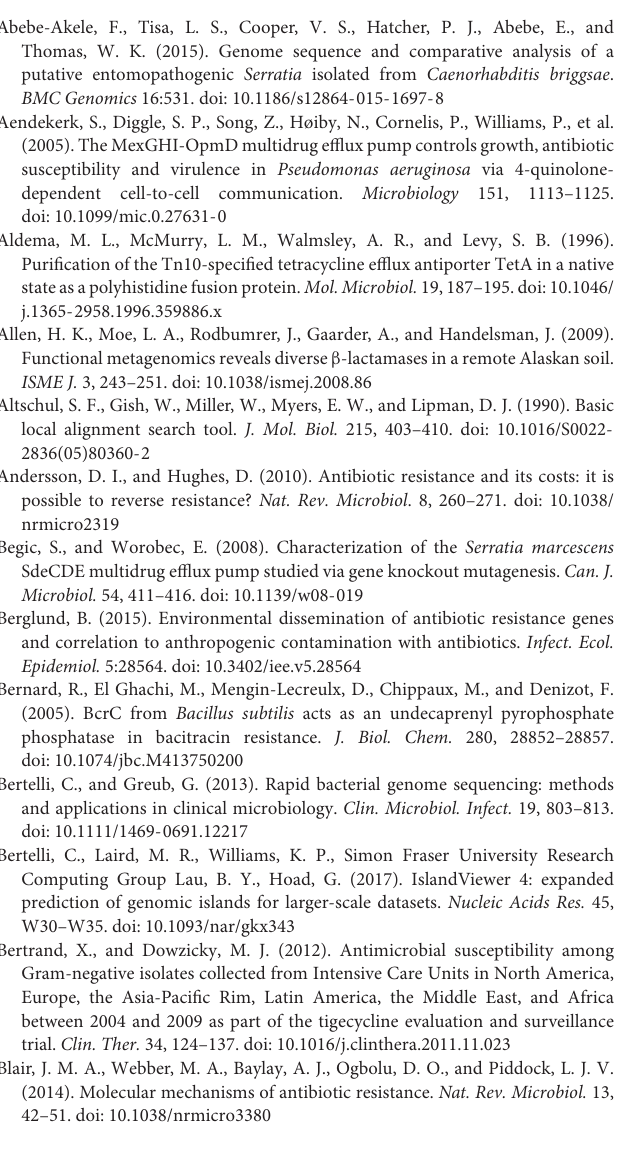
FIGURE S3 | Venn analysis of the pan-genome of the 32 Serratia spp. genomes generated by COG and OMCL algorithms. TABLE S1 | List of the 32 Serratia spp. genomes used in this study, source of isolation, geographic region, continent, NCBI genome reference number, and genome size. TABLE S2 | Total number of ARGs and efflux pumps identified in the 32 Serratia genomes. Genes found on the chromosome in white color, genes found on plasmids in orange color, genes found on transposons in blue color, genes found on probable genomic islands in purple color, regulatory genes in pink color and genes with mutations that confer resistance in green color. TABLE S3 | Plasmids and acquired ARGs of the 32 Serratia spp. genomes. β -lactam resistance genes: blue, aminoglycoside resistance genes: red,